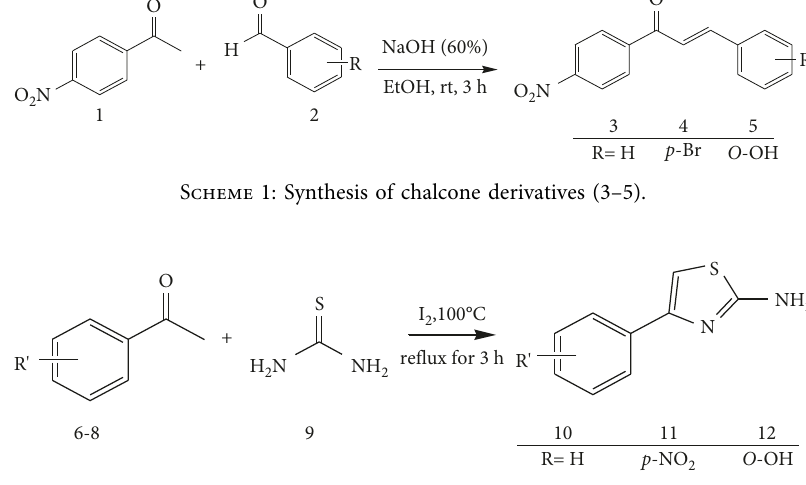
Scheme 2: Synthesis of 2-amino-4-(substituted-phenyl)thiazole derivatives